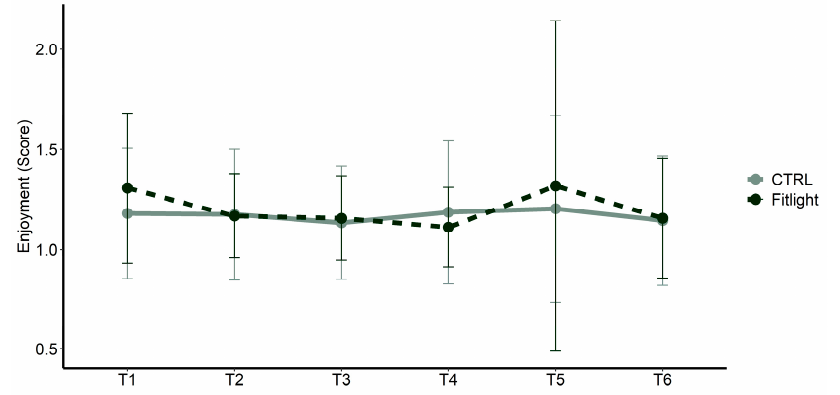
Figure 5. Enjoyment scores measured over time and between groups in all conditions.